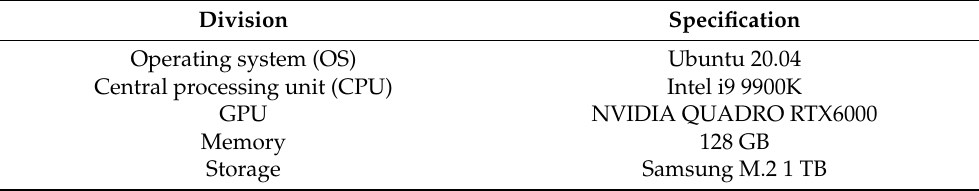
Table 1. Configuration of development environment.